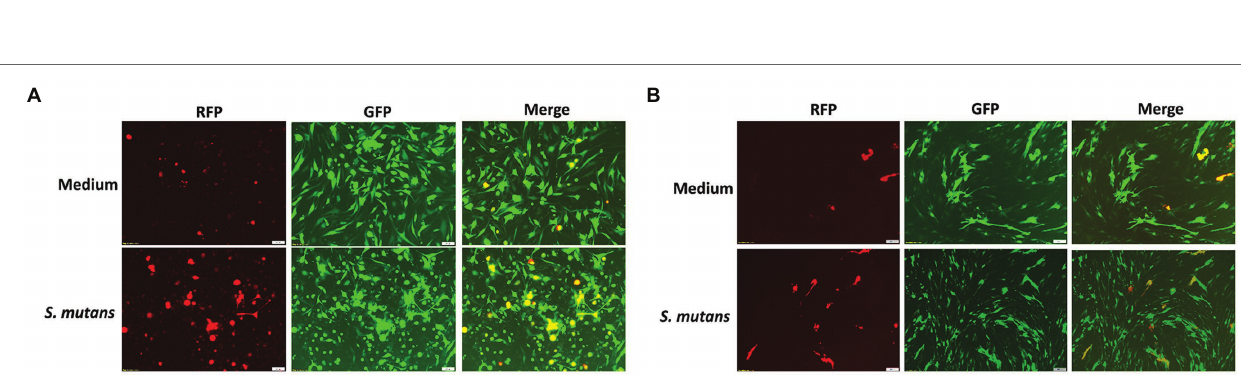
FIGURE 5 | Induction of KSHV lytic gene expression by conditioned medium from Streptococcus species. (A,B) Oral fibroblasts periodontal ligament fibroblasts (PDLF) and human gingival fibroblasts (HGF) were infected with purified rKSHV.219 virus (MOI ~ 5) for 2 h. A 24 h later, cells were treated with filtered conditioned medium from Streptococcus salivarius C699 or Streptococcus mutans NCTC 10449 strain culture or fresh medium as a control (diluted as 1:50) for additional 48 h. Viral gene expression was measured and quantified using qRT-PCR. Error bars represent the S.D. for three independent experiments. * p < 0.05; ** p < 0.01 (two-tailed Student’s t -test). PDLF, periodontal ligament fibroblasts; HGF, human gingival fibroblasts.